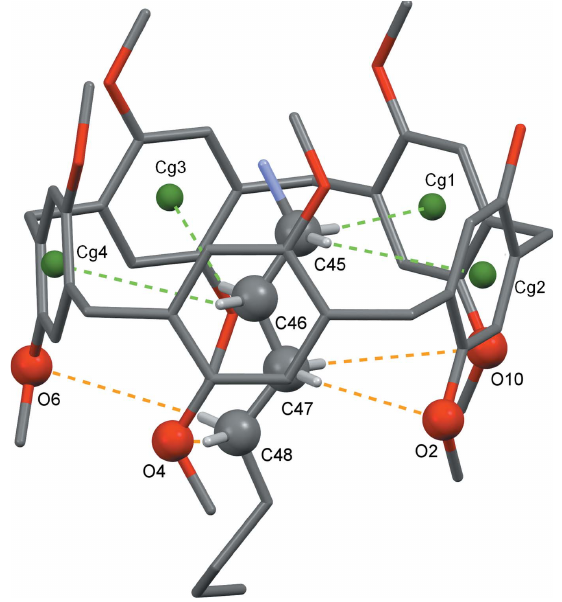
Figure 3 Crystal structure of the inclusion complex Pil-OH (cid:2) OctNH 2 showing weak C—H (cid:2)(cid:2)(cid:2) O and C—H (cid:2)(cid:2)(cid:2) (cid:2) interactions where Cg 1–4 are the centroids of the aromatic rings in the pillararene system. C—H (cid:2)(cid:2)(cid:2) O interactions are represented as brown and C—H (cid:2)(cid:2)(cid:2) (cid:2) as green dashed